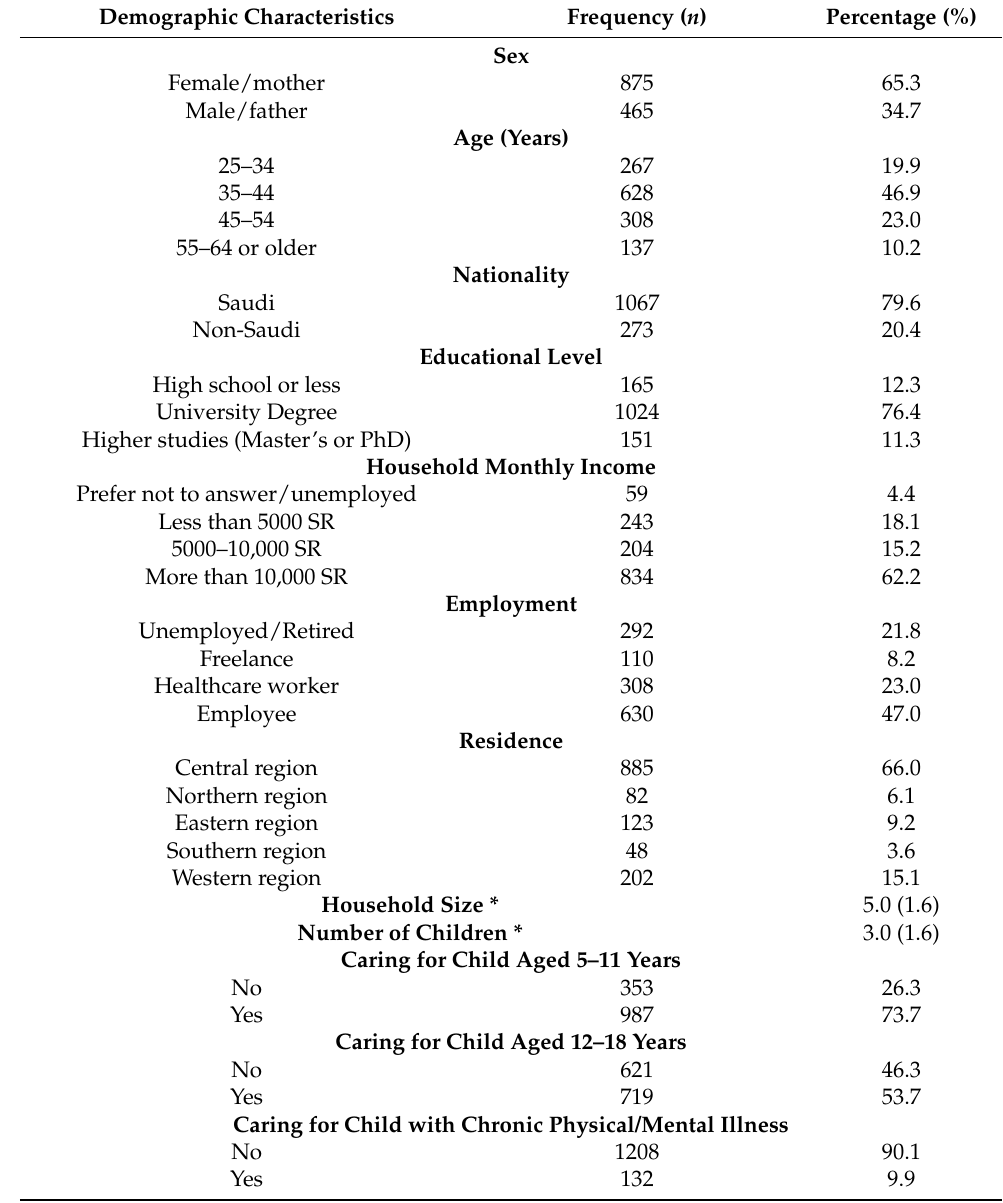
Table 1. Descriptive analysis of the parents’ sociodemographic